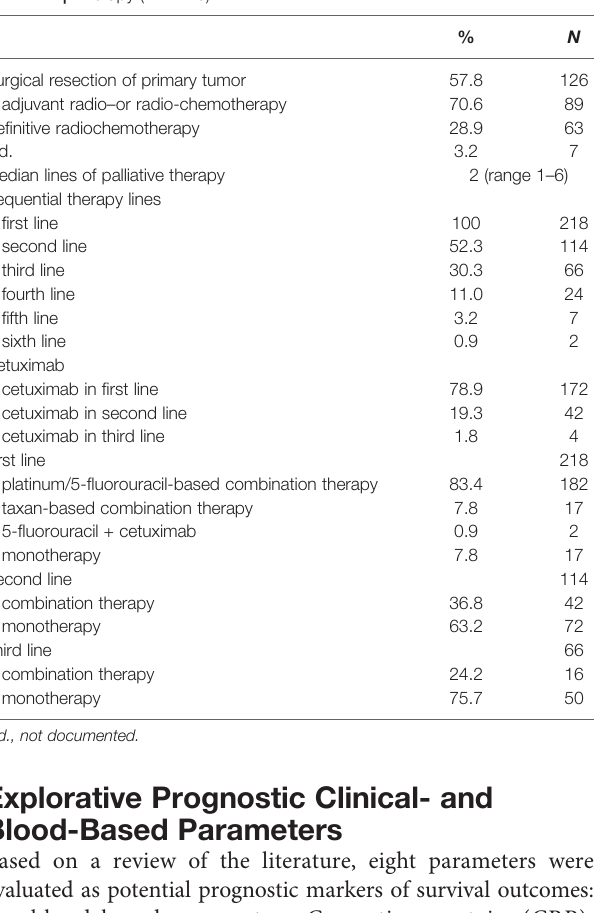
TABLE 2 | Therapy ( N = 218).